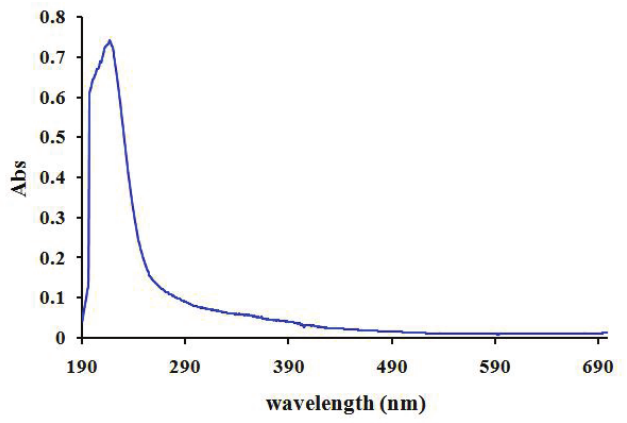
Fig. 5. UV-Vis spectrum of (BMIM)